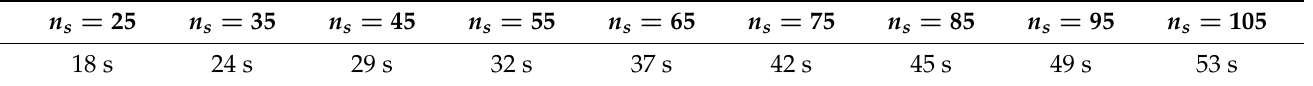
Table 1. The computational costs per time step with respect to different local-domain